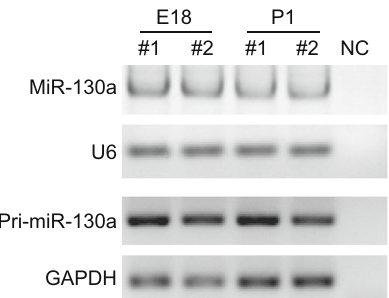
Figure 1. Expression of miR-130a in embryonic and postnatal rat brains. Rat cortical neurons were harvested from brains at the stages of E18 and P1. The levels of mature miR-130a (with U6 as an internal control) (upper panel) and primary miR-130a (with GAPDH as an internal control) (lower panel) were detected by RT-PCR. The last lane in each panel contained the negative control (NC) in which reverse transcriptase was omitted from the cDNA synthesis